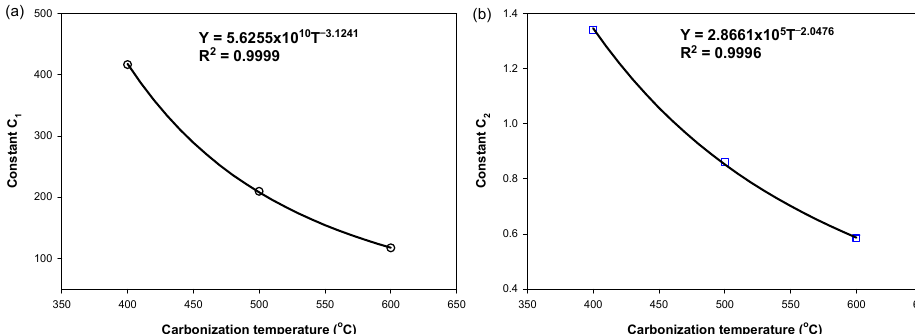
Figure 11. The relationship between the structural parameter and fractional conversion of char . Fig ‐ ure ( a – c ) refer to the activated carbon derived from char carbonized at 400, 500, and 600 °C for 90 min, respectively .